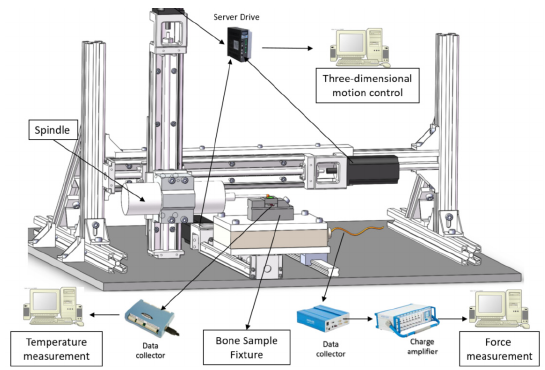
Figure 2. Schematic view of the three-dimensional bone grinding system.